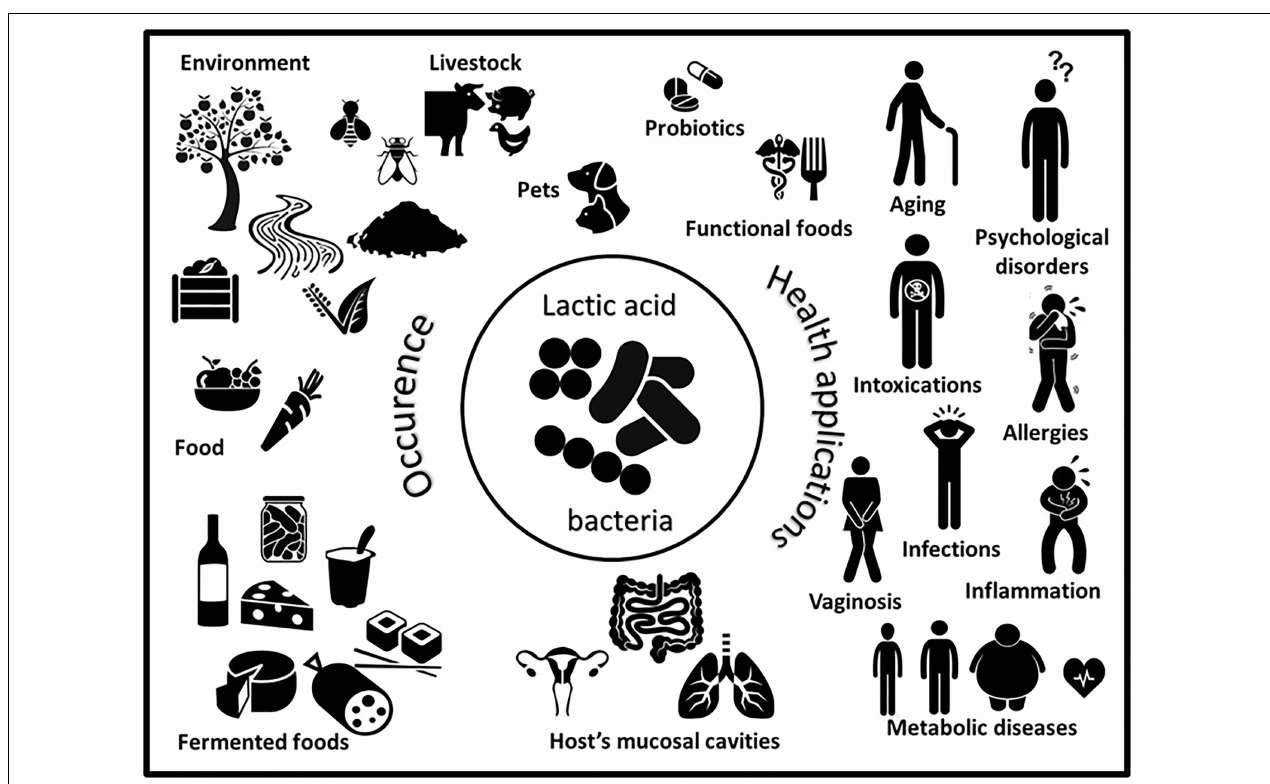
FIGURE 1 | Schematic representation of the worldwide occurrence (left) and multiple health applications (right) of lactic acid